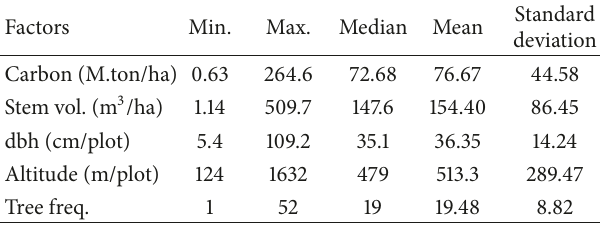
Table 2: Descriptive statistics of carbon, stem volume, dbh, altitude, and tree frequency.